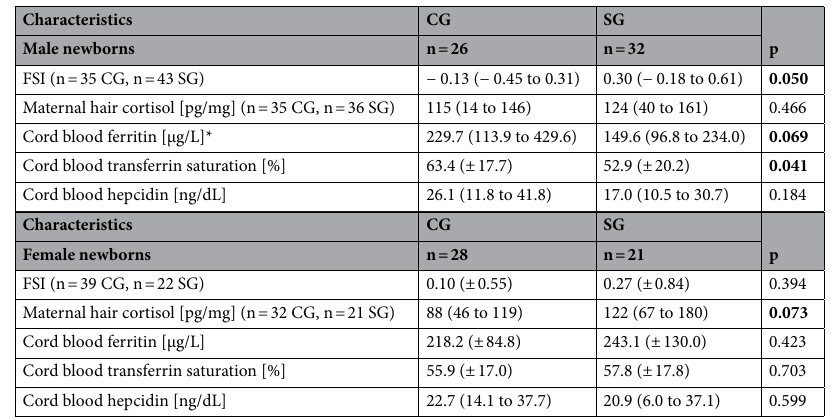
Table 1. Sex-specific effect of PS on biomarkers. Data are mean (SD) using t-test or median (interquartile range) using Mann–Whitney U test. Sample size is indicated as applicable. Differences with p-value < 0.1 are in bold. *Missing values for 1